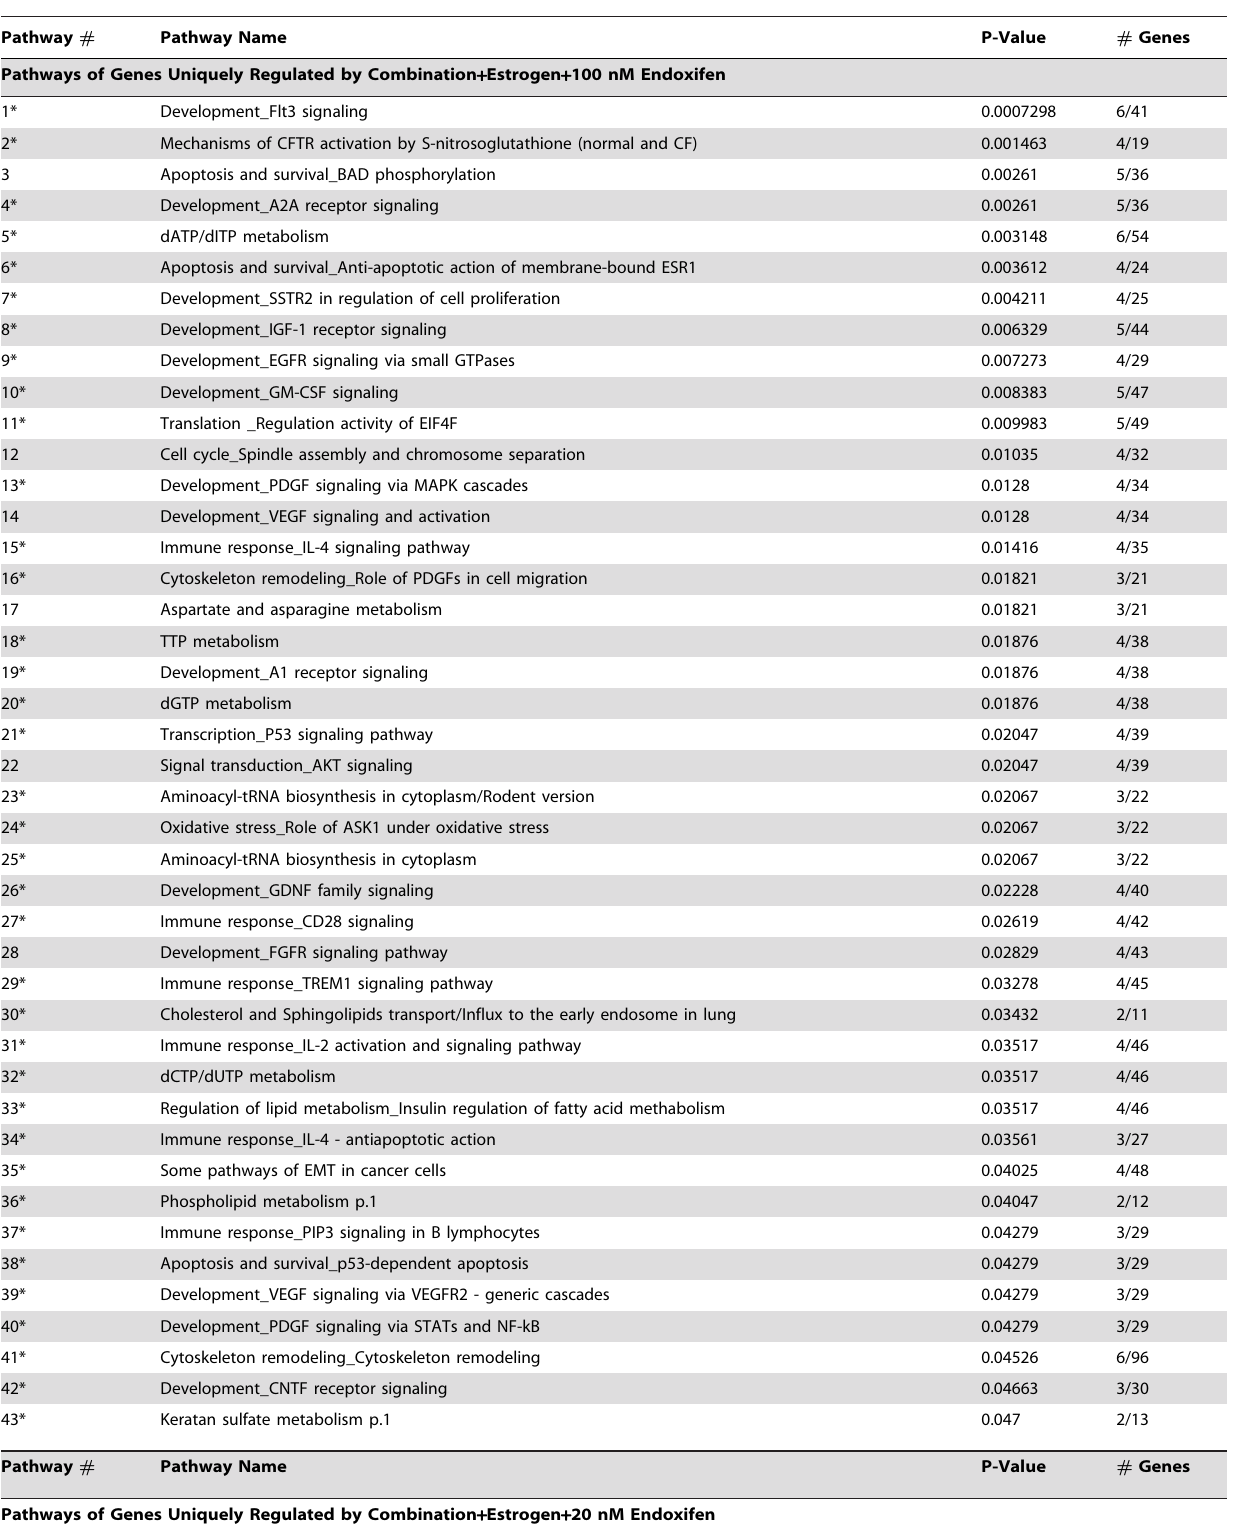
Table 1. Biological pathways detected to be significantly regulated based upon endoxifen concentrations under physiologically relevant